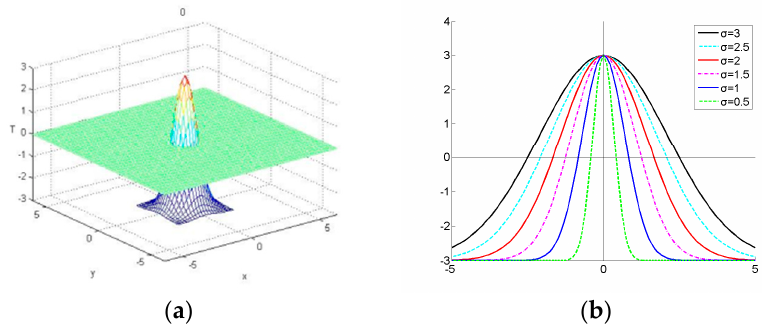
Figure 5. Simulation of the location constraint function: ( a ) display in three-dimensional; and ( b ) illustration of 2-D cross section of the location constraint function with different shape parameters σ .